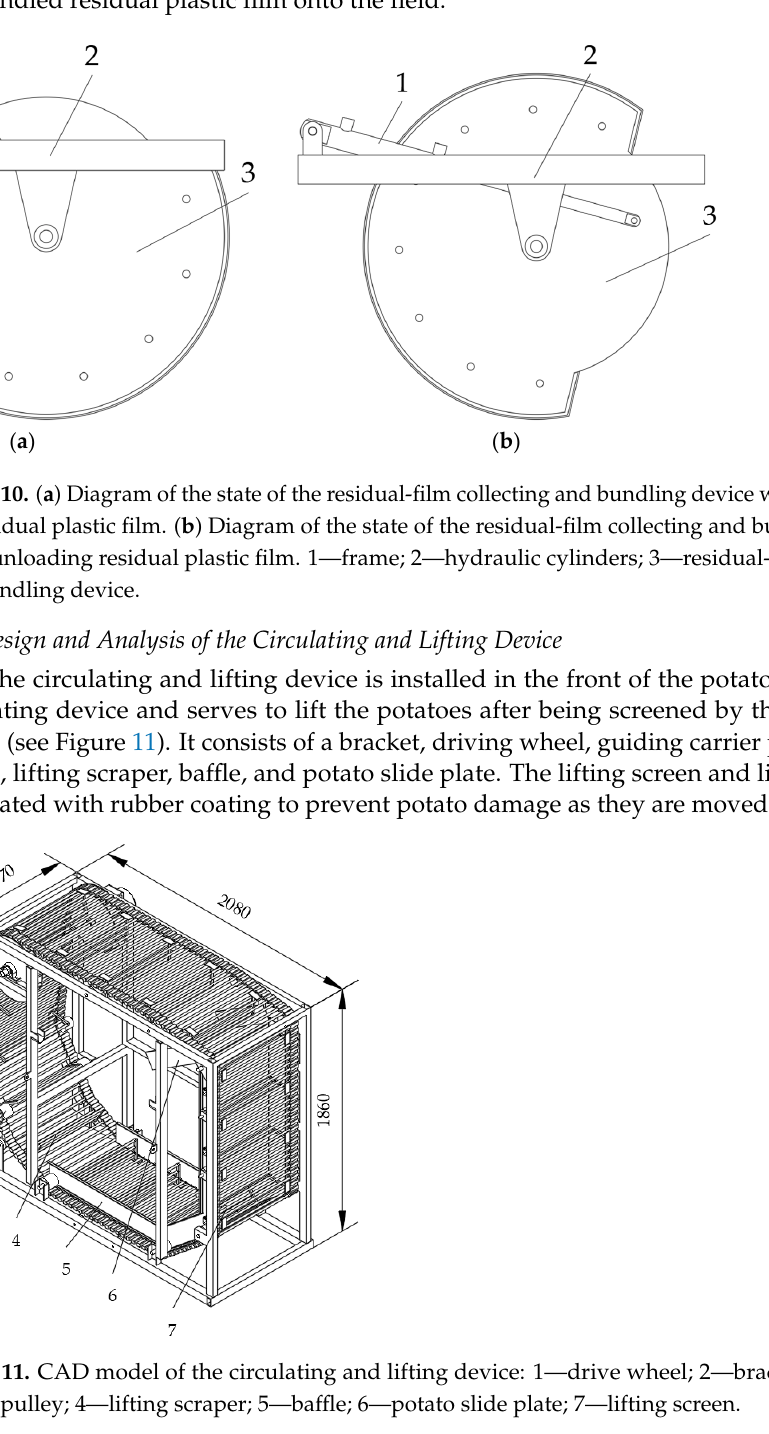
Figure 12. Force analysis diagram of a potato in the receiving section of the circulating and lifting device. In Figure 12, point I is the position of the center of mass of the potato when at the lower end of the potato–plastic- fi lm separation device. Point J is the intersection of the potato’s trajectory and the upper end of the lifting scraper after the potato is thrown, and point K is the impact point between the potato and the lifting-screen rod of the circulating and lifting device. For a fi xed reference frame with its origin at point I (Figure 12), the equations of motion of the center of mass of the potato are: 2 2 1 2 3 2 3 2 x=-v t cos y=-v t sin